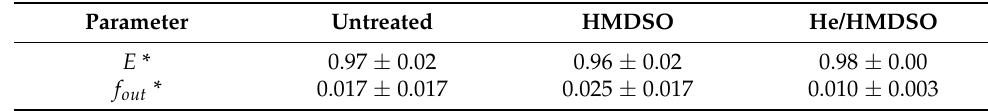
Table 5. Normalized entropy ( E ) and fraction of outliers ( f out ) in the LRMS (x,y) of the untreated and treated starch films. Parameter Untreated HMDSO He/HMDSO E * 0.97 ± 0.02 0.96 ± 0.02 f out * 0.010 ±